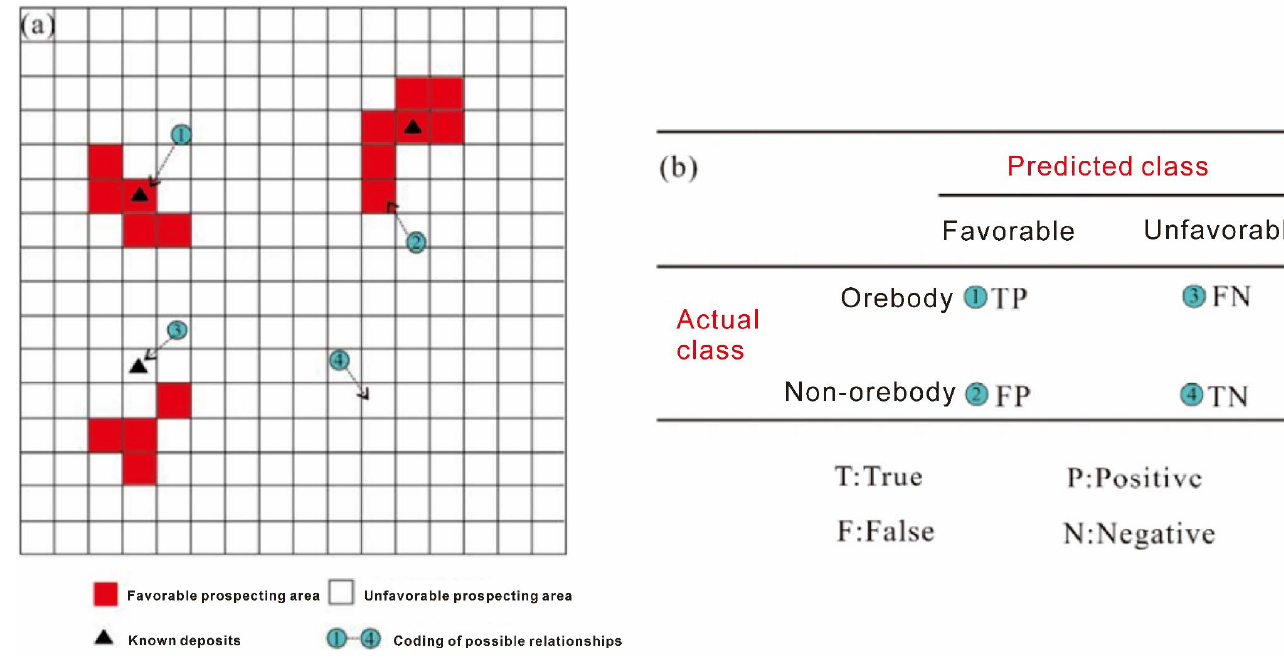
Figure 10. The spatial relationship and the confusion matrix: ( a ) the spatial relationship between prediction results and known mineral deposits (points) and ( b ) the confusion matric for four types of relationships [41].